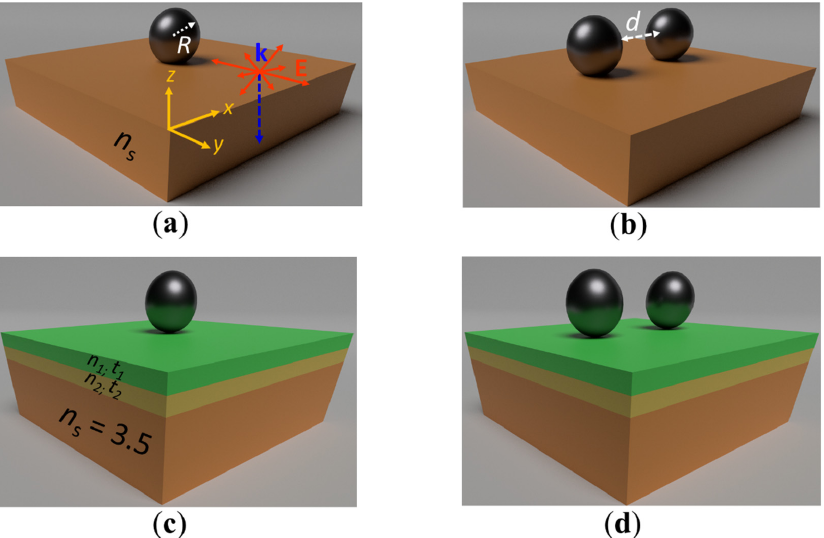
Figure 1. Scheme of the different analyzed HRID (silicon) configurations of spherical particles on a monolayer ( a , b ) and a multilayer ( c , d ) substrate of known optical properties. ( a , c ) Isolated particle, ( b , d ) dimer. All particles had a radius R = 150 nm. The gap distance between the particles was d = 10 nm. For the monolayer substrate, its refractive index was varied in the interval n s ∈ [1.5–3.5]. The graded-index multilayer system consisted of two dielectric antireflection layers on a silicon substrate ( n s = 3.5). The thickness t and refractive index n of each layer were t 1 = 185 nm, t 2 = 104 nm and n 1 = 1.396, n 2 = 2.474, respectively. All geometries were illuminated by an unpolarized plane wave propagating along the - z -axis.